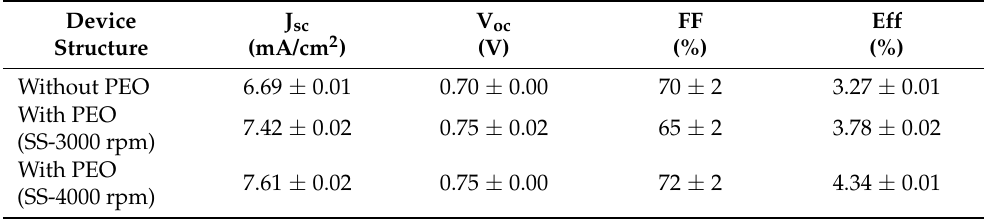
Table 2. Device parameters as open-circuit voltage (V oc ), short-circuit current density (J sc ), fill factor (FF) and power conversion efficiency (PCE) from J-V characteristics without and with different PEO buffer layer thickness under A.M 1.5G illumination at 100 mW/cm 2